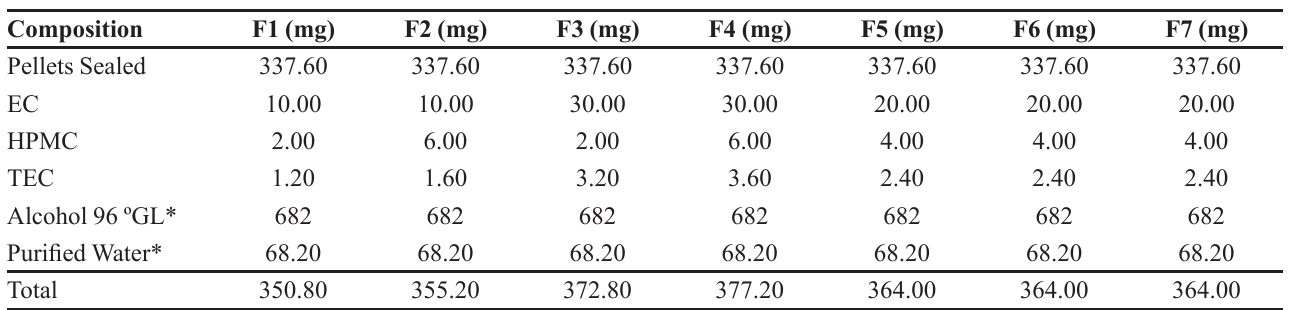
TABLE IV - Formulation for obtaining modified release pellets